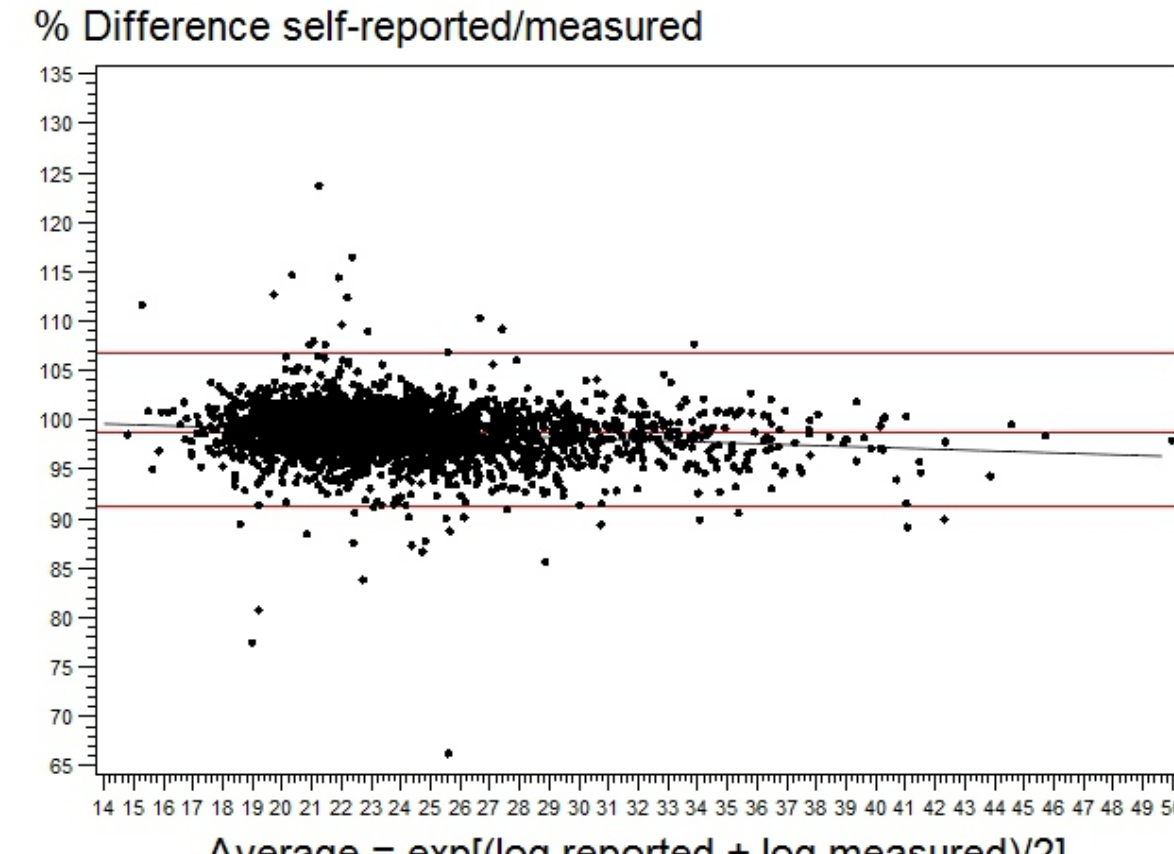
Figure 1. Bland - Altman plot of self-reported versus measured values of BMI, NutriNet-Santé study, 2012, France. Horizontal lines represent the % mean difference and 95% limits of agreement.